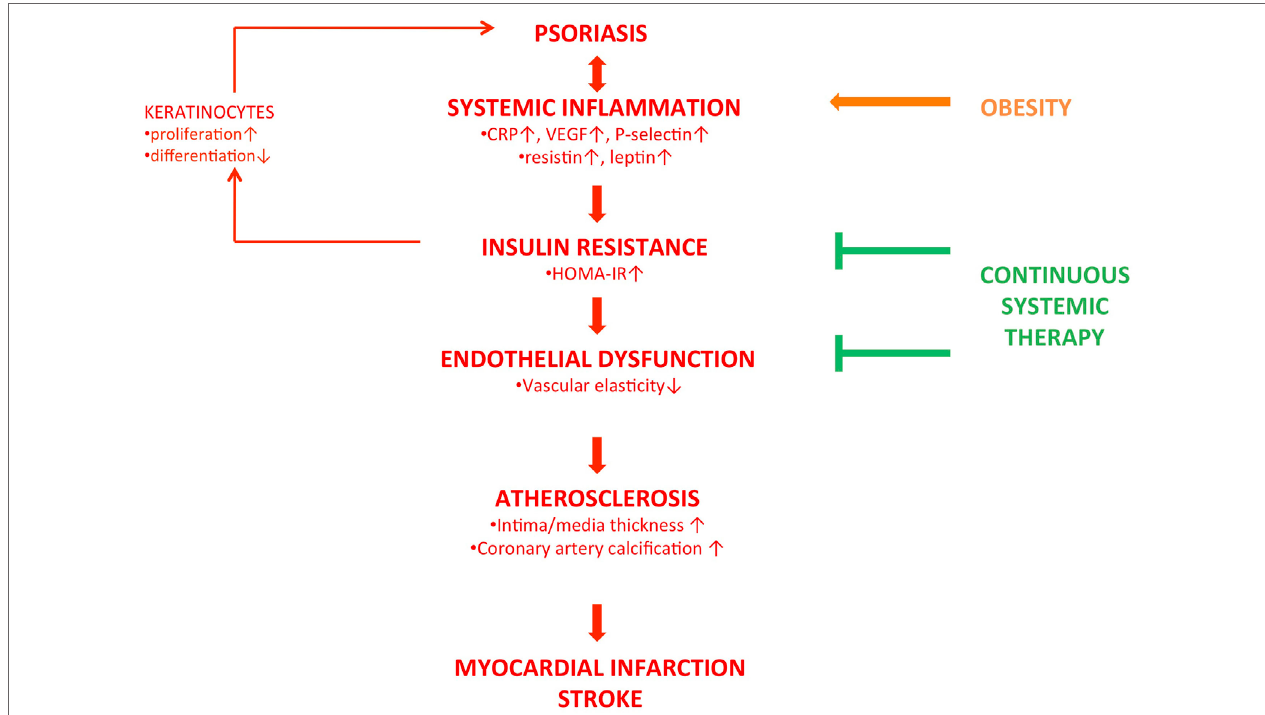
FiGURe 2 | The concept of the “psoriatic march.” This hypothesis suggests that psoriasis is a systemic inflammatory condition, as numerous biomarkers of inflammation are elevated in the patients’ blood compartment. Functional consequences are insulin resistance, evidenced by an increased HOMA-IR (homeostasis assessment of insulin resistance), and endothelial dysfunction, resulting in increased vascular stiffness. This provides the basis for atherosclerosis, observable through analysis of vessel wall composition via CTs or ultrasound. Depending on the sites of atherosclerosis, major cardiovascular events such as myocardial infarction and stroke result from this. This “backbone” (red, bold) may be developed further by adding additional “modules”: insulin resistance has been shown to alter epidermal homeostasis (red, fine). Obesity, causing a state of systemic inflammation as well, is a known risk factor for psoriasis and may induce the phenotype (orange, bold). Whether systemic anti-inflammatory therapy is capable of reducing the patients’ cardiovascular risk through reducing insulin resistance and endothelial dysfunction is still a matter of debate